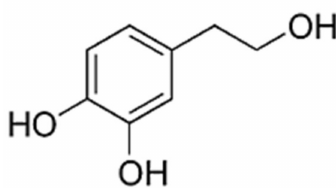
Figure 1. Molecular structure of free